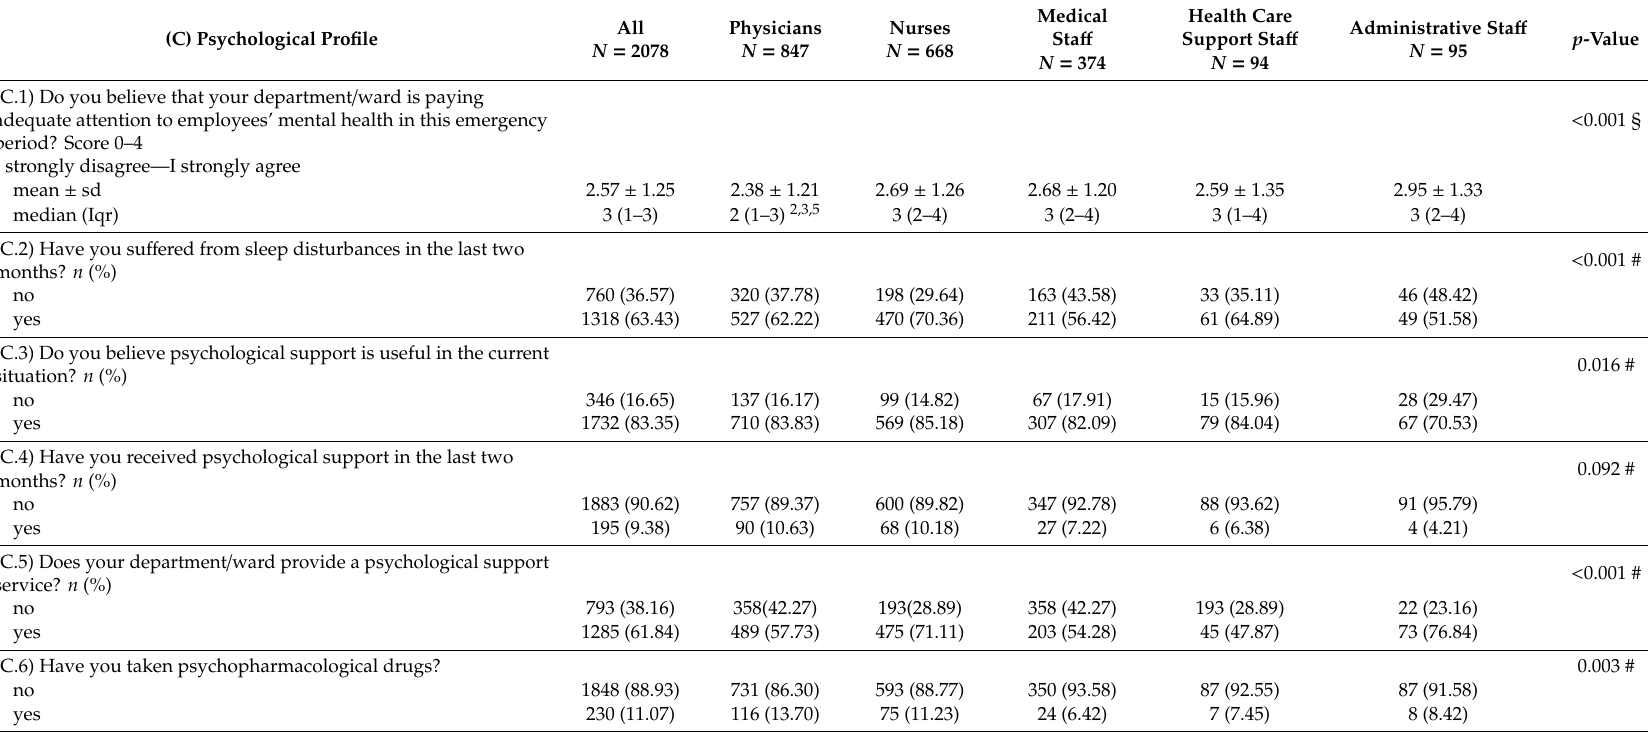
Table 4. Health care workers’ psychological